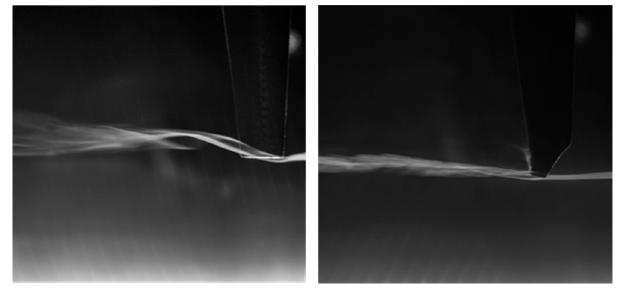
Figure 17. Time-averaged axial velocity ( a ), time-averaged normal velocity ( b ), and vorticity ( c ), with winglet.